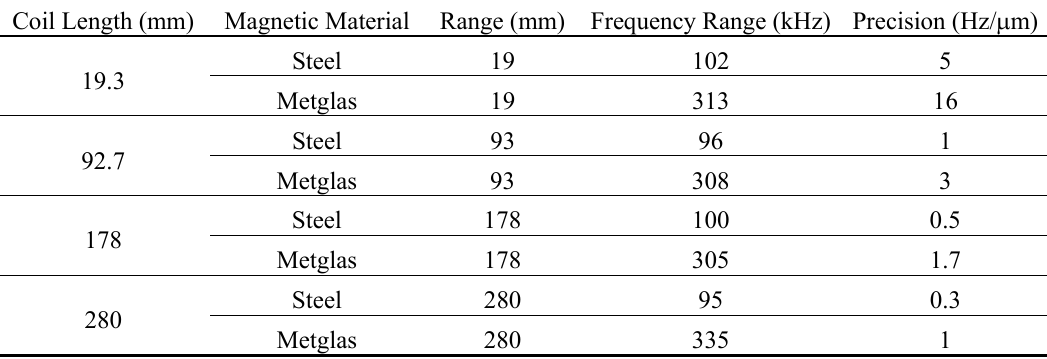
Table 2. Transducer thresholds detection for different coils.